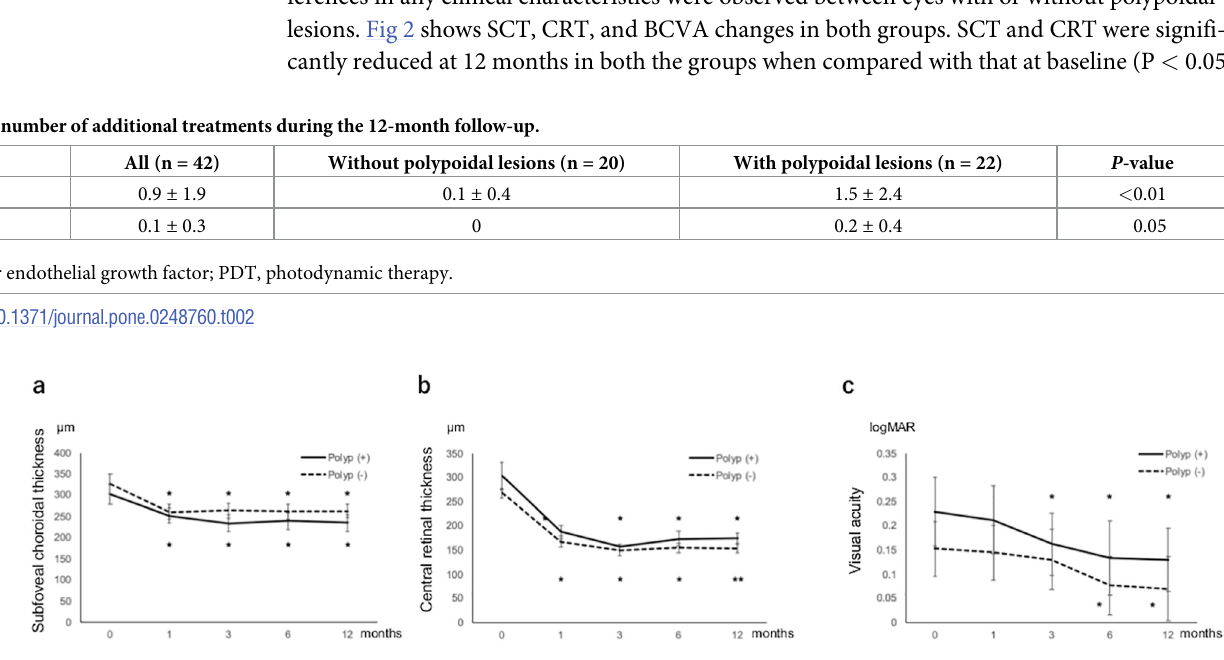
Fig 2. Changes in subfoveal choroidal thickness (a), central retinal thickness (b), and best-corrected visual acuity (c) during the 12-month follow- up period in eyes with pachychoroid neovasculopathy with or without polypoidal lesions. Each eye was treated with photodynamic therapy combined with intravitreal injections of an anti-vascular endothelial growth factor agent. No statistically significant difference in subfoveal choroidal thickness, central retinal thickness, and best-corrected visual acuity was observed between the two groups at any time points. � P < 0.05, �� P < 0.01, compared with baseline values. Data are expressed as mean ± standard